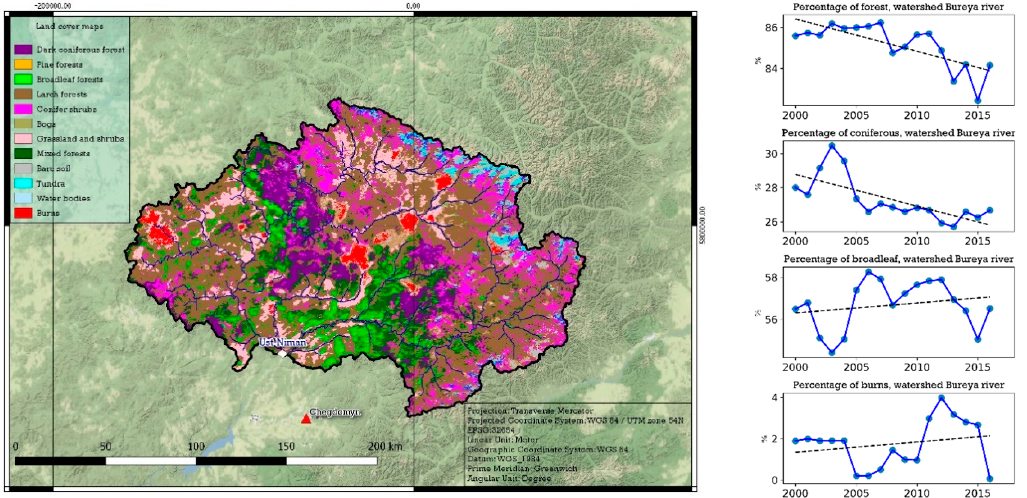
Figure A1. Vegetation dynamics of Bureya River watershed. Stream gaging is marked with the white diamond.